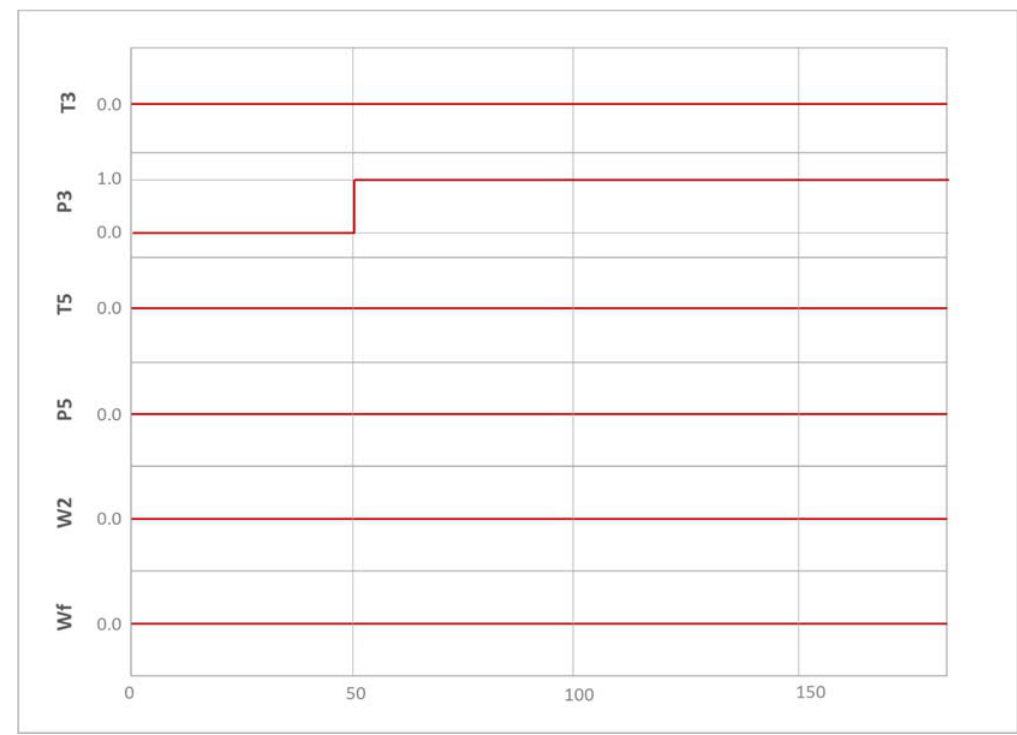
Figure 15. BN predictions of sensor status in Scenario 3 for P3 sensor fault. 0 means no fault and 1 means fault.